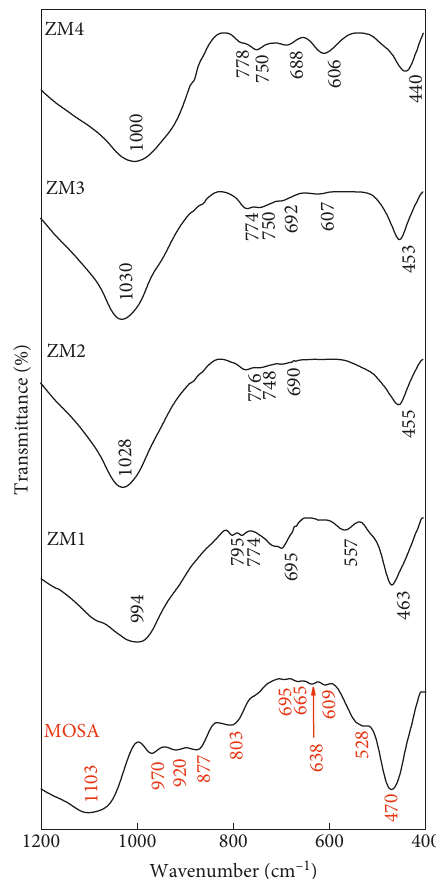
Figure 4: FTIR spectra of MOSA and synthesis